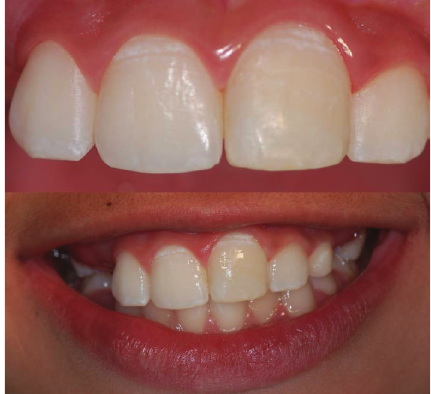
Figure 11: Clinical aspect after 12